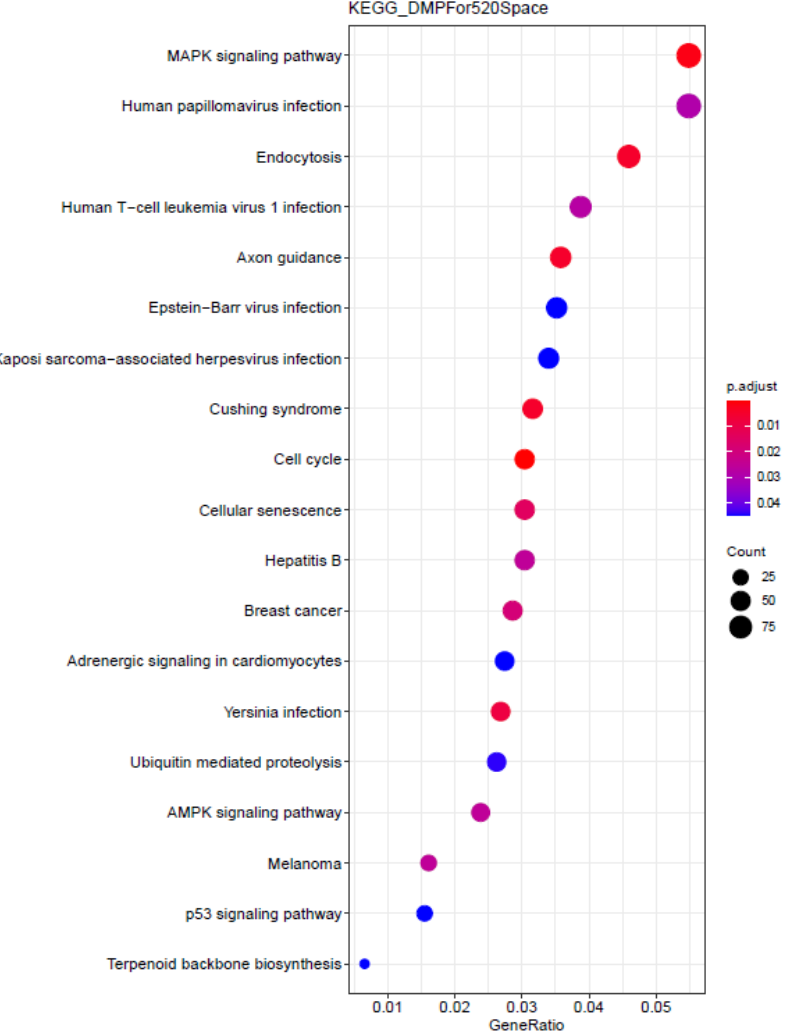
Figure 2. KEGG enrichment pathways of differential methylated genes in Mars 520. The KEGG en ‐ richment analysis of 4428 differentially methylated genes included 5 pathways associated with viral infections, including Human papillomavirus (HPV) infection, Human T cell leukemia virus 1 (HTLV1) infection, Epstein Barr virus (EBV) infection, Kaposi Sarcoma ‐ Associated Herpesvirus (KSHV) infection and hepatitis B. The horizontal axis represents GeneRatio, which is the ratio of genes enriched in the corresponding pathway to the input genes; the dot size in the figure was de ‐ termined by the number of genes enriched in the corresponding pathway and the dots in the figure were arranged from top to bottom as number became smaller; the color is determined by “adjust p ‐ value”, which was the false discovery rate provided by the KEGG enrichment